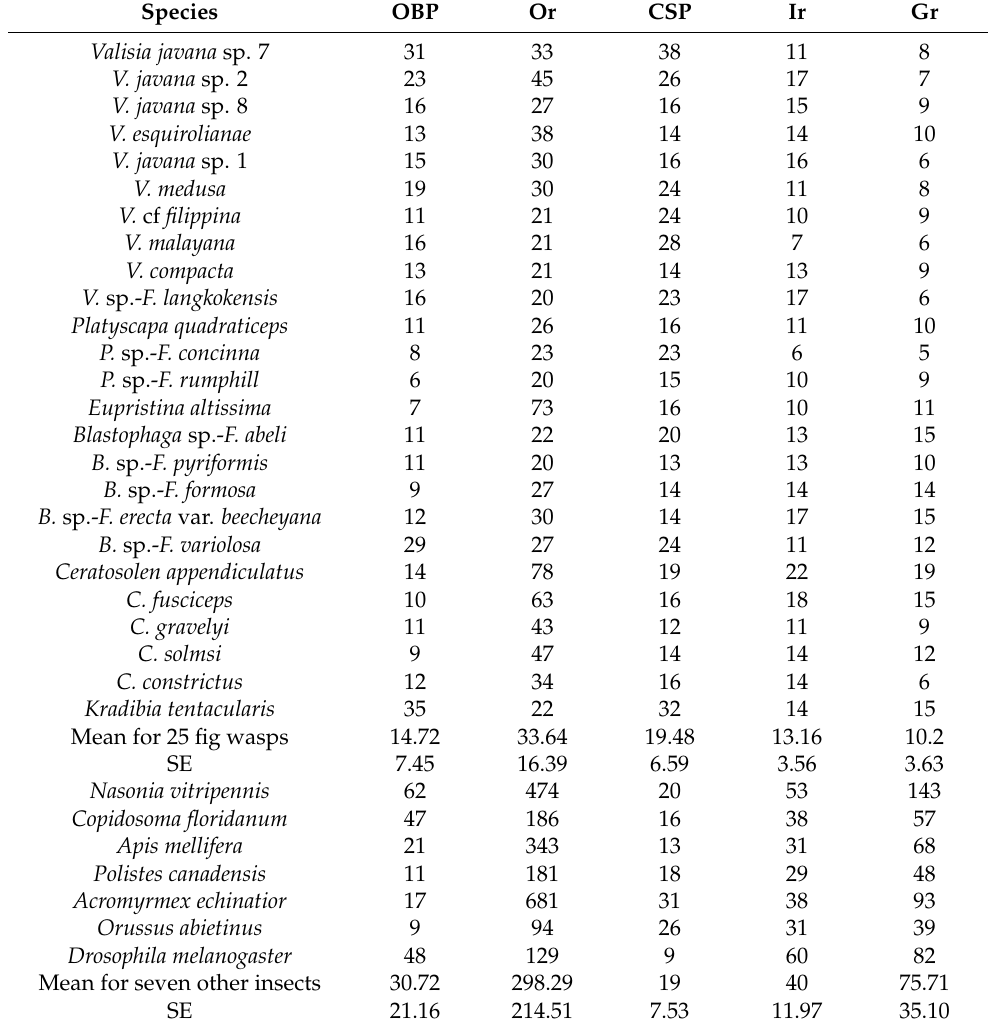
Table 3. Numbers of OBP, Or, CSP, Ir, and Gr genes among 25 fig wasps and 7 other insect